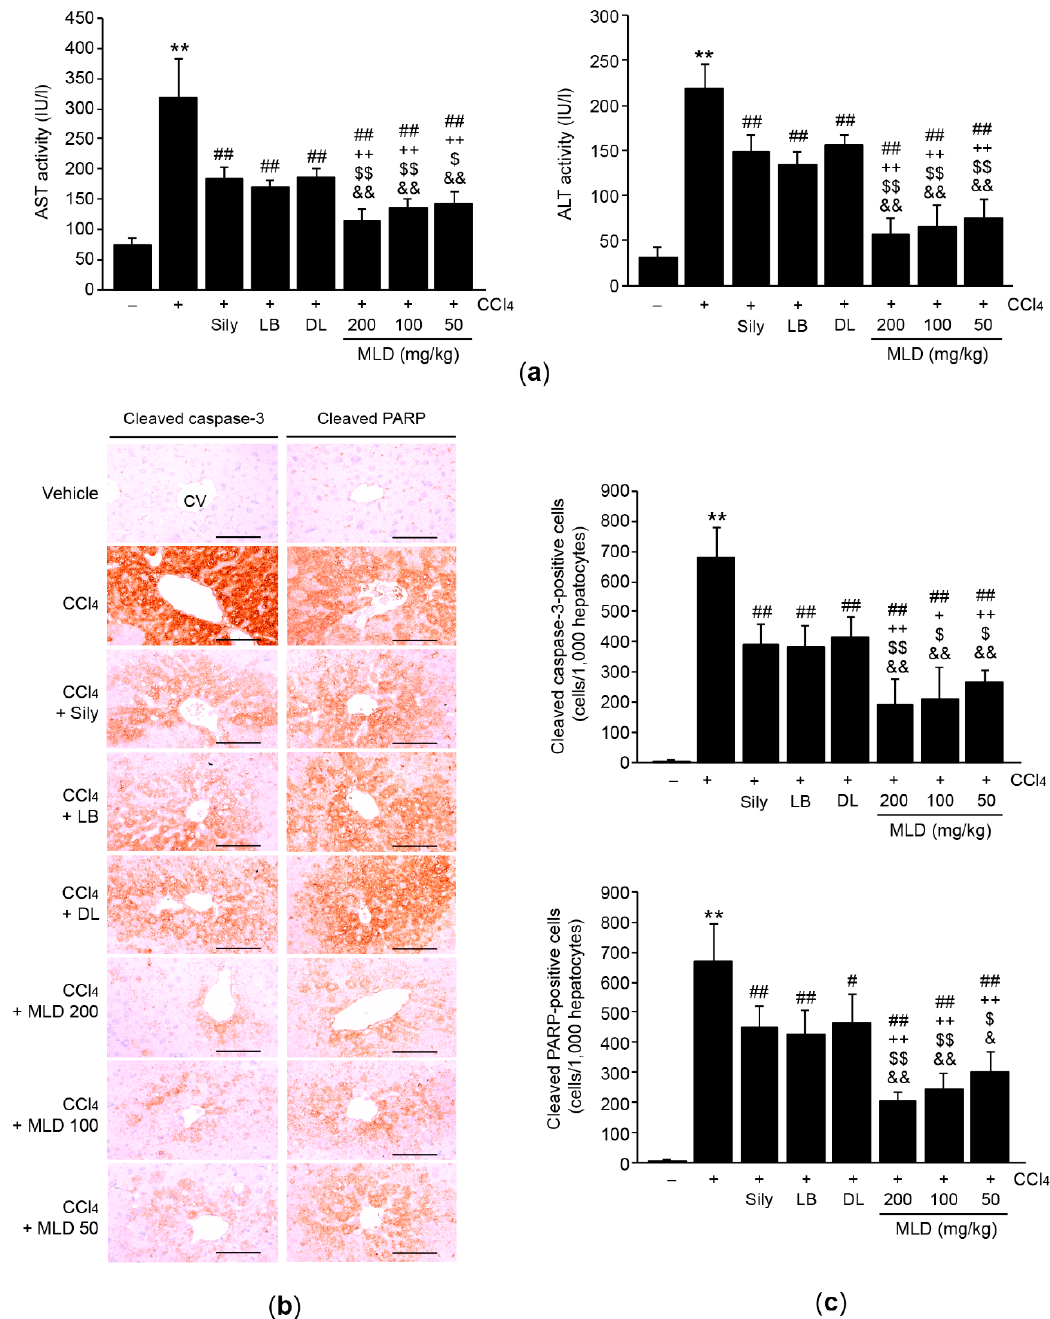
Figure 3. MLD attenuates apoptosis of hepatocytes. ( a ) Effects of MLD on serum AST and ALT activities. ( b ) Hepatic tissues were immunostained using cleaved caspase-3 or cleaved polymerase (PARP) antibodies. Scale bars, 200 μ m. ( c ) Positive cells in the hepatic parenchyma around the central vein were counted. All values are expressed as mean ± SD of ten mice. ** p < 0.01 between the vehicle and CCl 4 groups; ## p < 0.01, # p < 0.05 versus CCl 4 -injected mice; ++ p < 0.01, + p < 0.05 between Sily- and MLD-treated mice; $$ p < 0.01, $ p < 0.05 between LB- and MLD-treated mice; && p < 0.01, & p < 0.05 between DL- and MLD-treated mice. CV, central